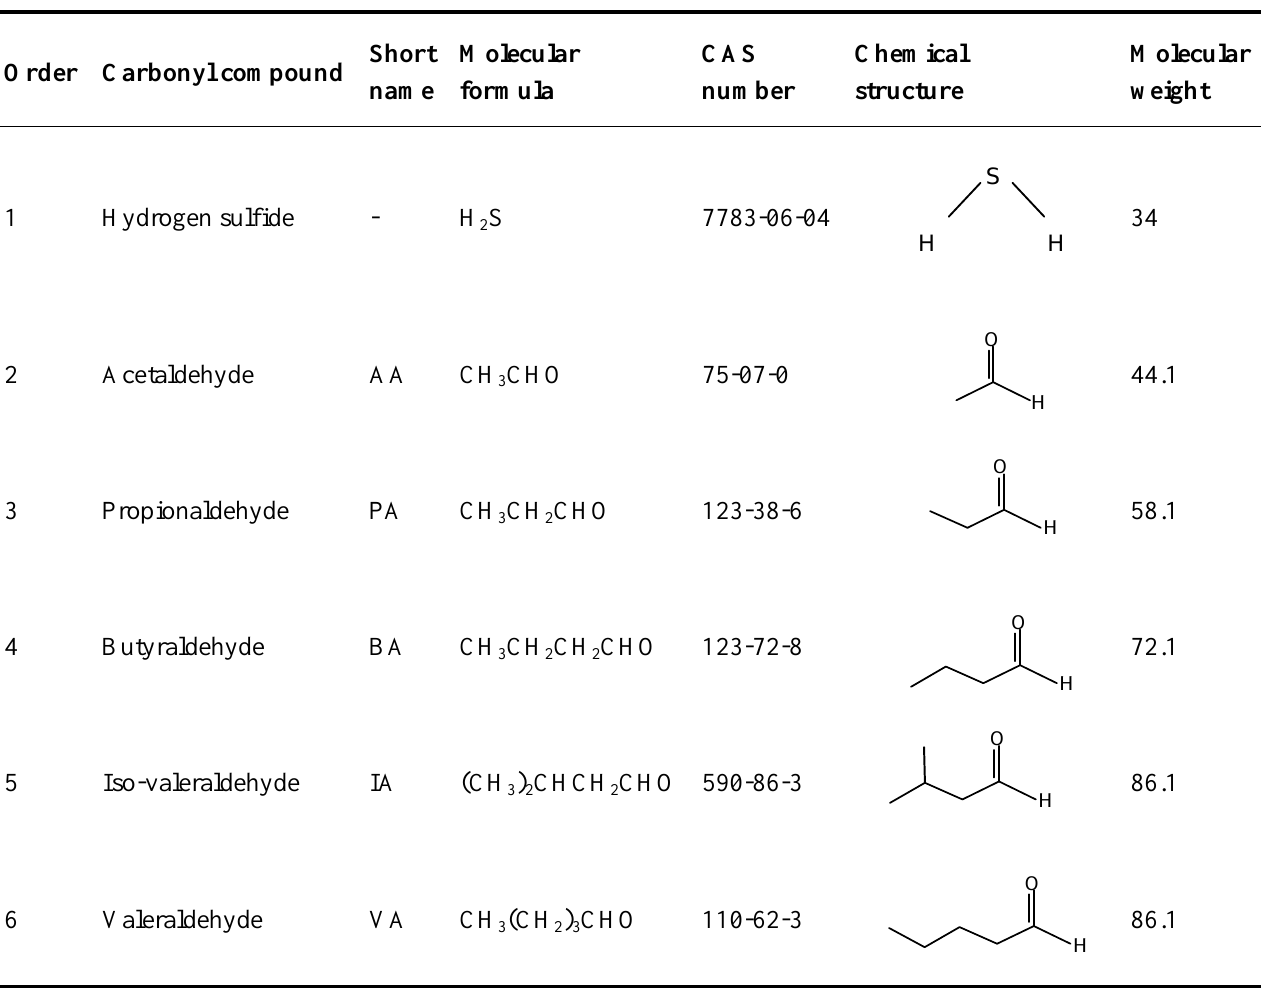
Table 1. List of target compounds investigated for relationship with dilution-to-threshold (D/T)